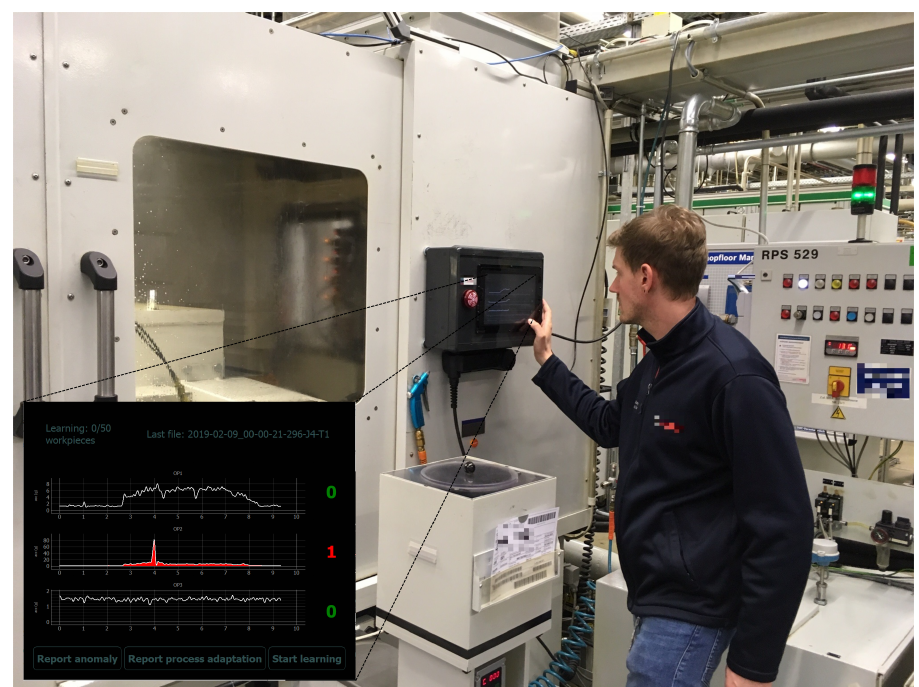
Figure 1. Surroundings for online annotation: Our developed prototype visualizes sensor signals and allows for live and in situ annotation of anomalies and process adaptations (reactive to predictions by anomaly detection algorithms or initiated by the machine’s operator). An exemplary screenshot of the default screen is illustrated in the lower left corner. Live annotation allows for a less time-consuming and thus cheaper way of gathering labels than via retrospective annotation by domain